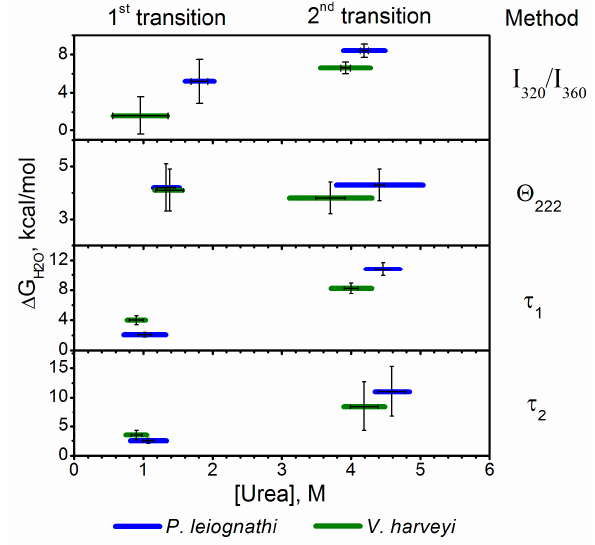
Figure 4. The urea concentration ranges of the structural transitions for the luciferases from V. harveyi (green) and P. leiognathi (blue) and corresponding ∆ G H2O , as determined by different techniques (Table 1). The length of the sticks reflects the transition width k i in accordance with the parameters obtained by fitting with a Boltzmann function; the middle of the sticks is the transition midpoint [Urea] 50% .